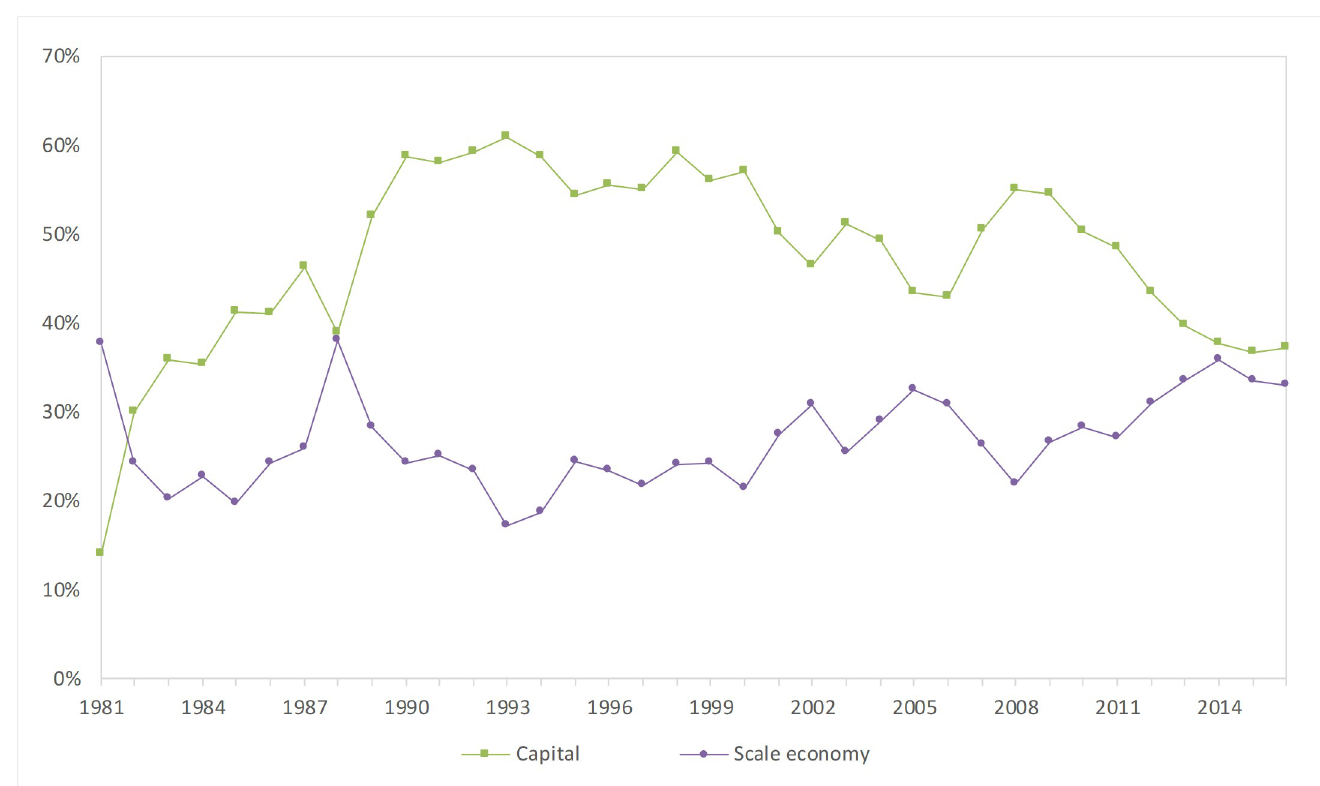
Fig 2. Trends of the scale economy and capital contribution